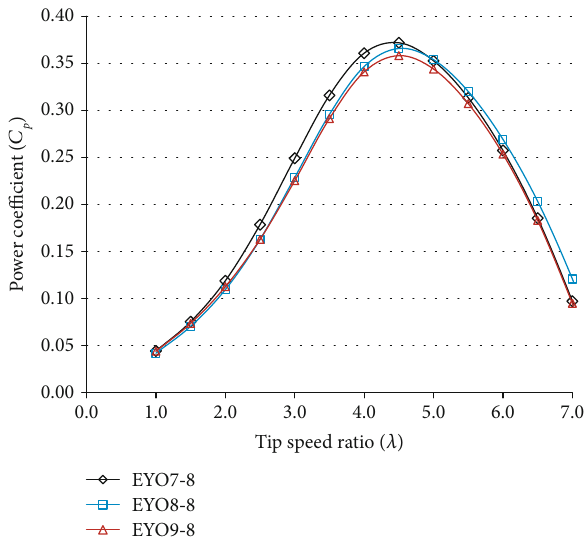
Figure 9: Power coe ffi cient curve for wind turbine